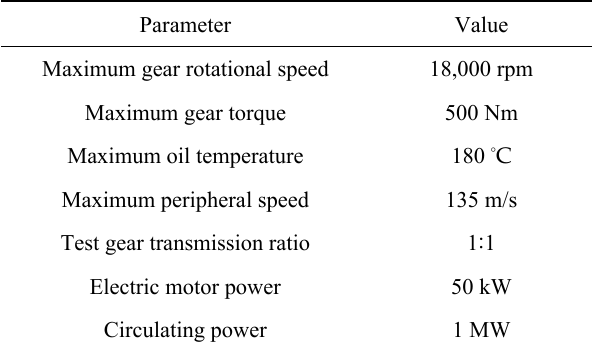
Table 3 Main parameters of closed loop gear test rig.